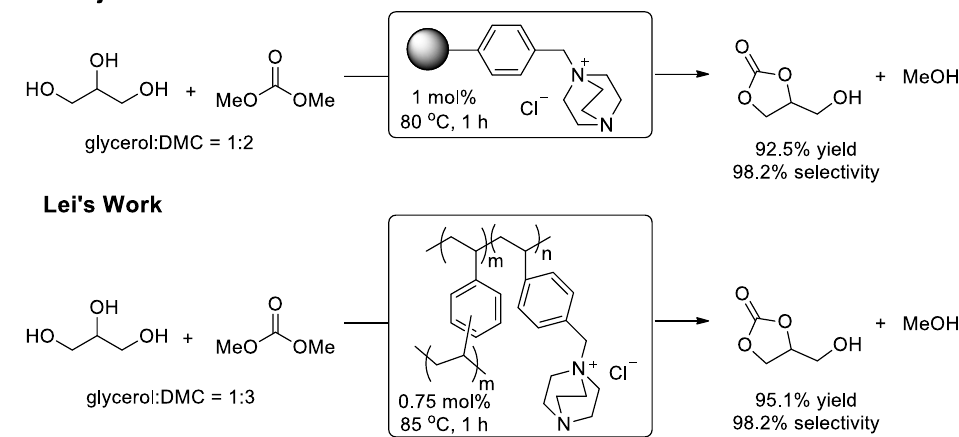
Figure 10. DABCO-derived heterogeneous catalysis in the transesterification of glycerol.